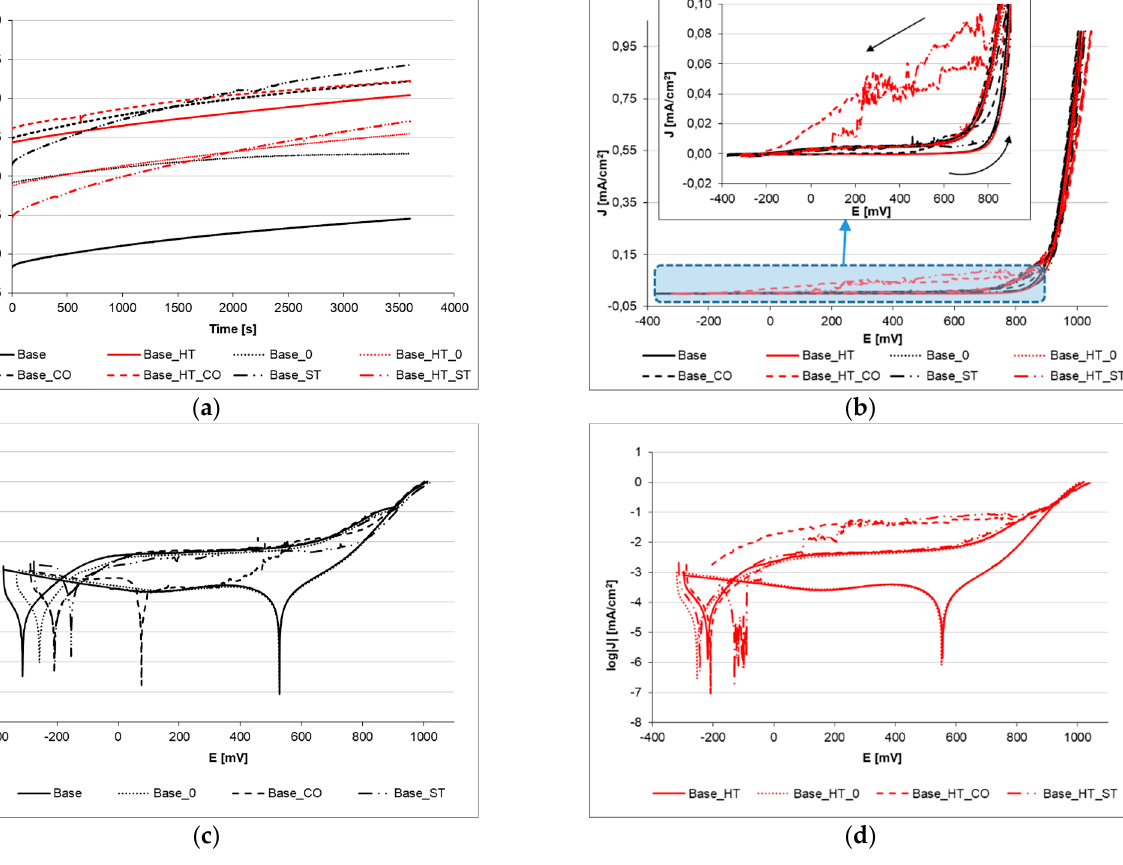
Figure 1. Electrochemical study results of welded CoCrMoW base alloy with (HT) and without (0) subsequent heat treatment for different filler materials—cobalt (CO) and stainless steel (ST) wires, as follows: ( a ) open circuit potential, ( b ) anodic polarization curves, ( c , d ) logarithmic presentation of anodic polarization curves for samples without and with HT. Table 4. Potentiodynamic test results of welded joint configurations (base CoCrMoW alloy, au- togenous welded base alloy, welding with CoCr wire, and stainless steel wire), with or without heat treatment.